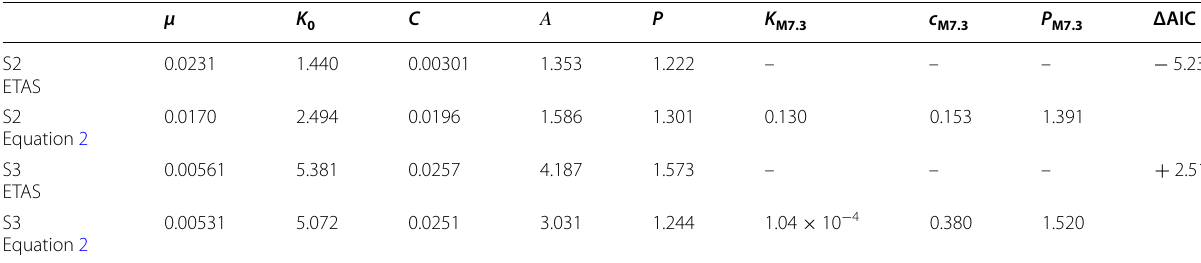
Table 8 Model comparisons between the ETAS model with and without the triggering effect